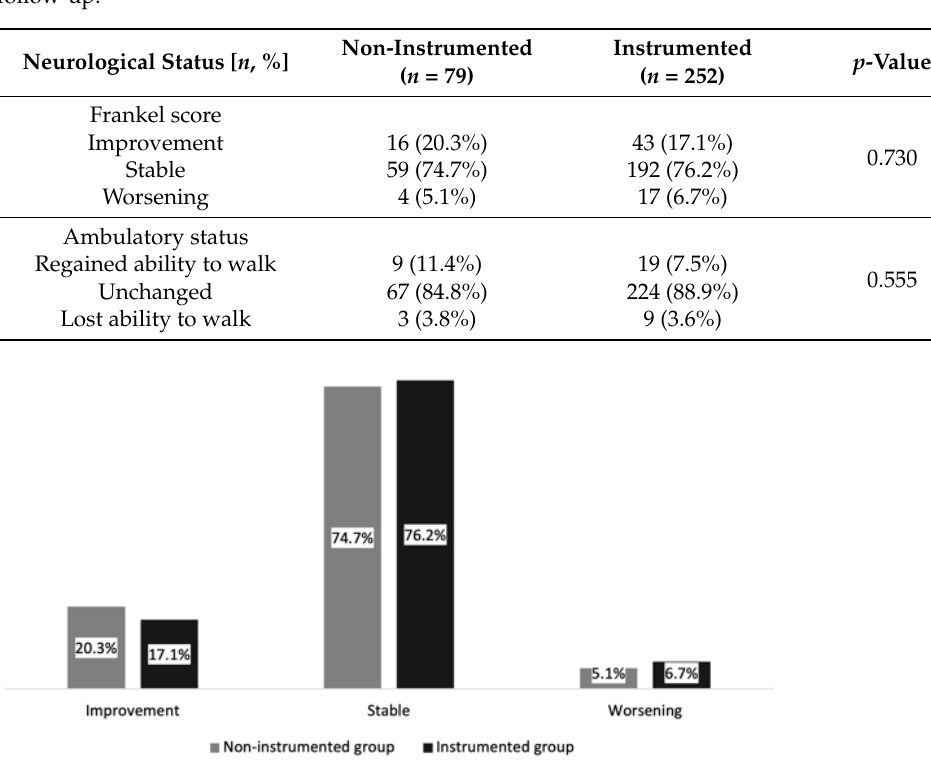
Figure 3. Changes in Frankel score: the instrumented and non-instrumented groups in the study cohort.